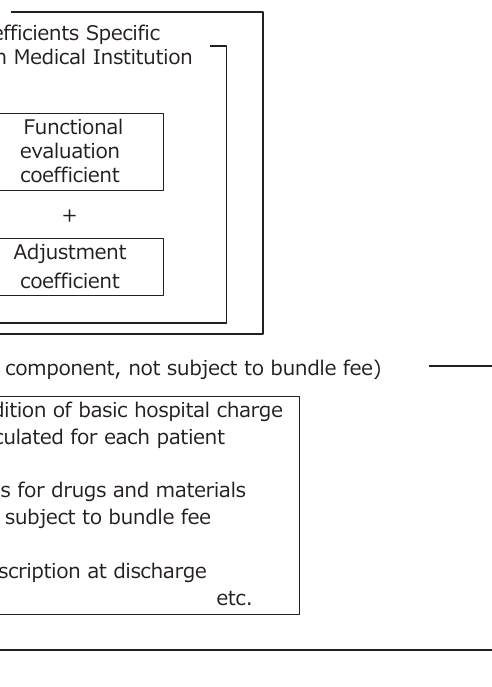
Figure 5. Composition of DPC-based medical service fee payment (as of